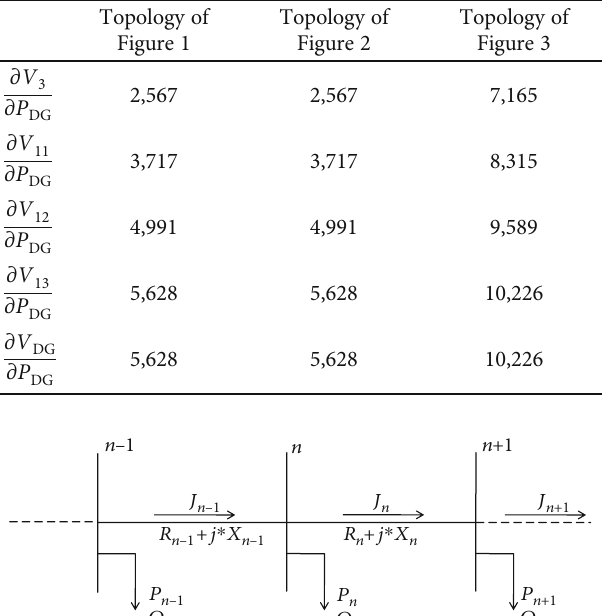
Figure 1: Single-line diagram of two meshed IEEE 15-bus feeders. Table 1: Voltage sensitivity analysis with respect to the active and reactive power variations.